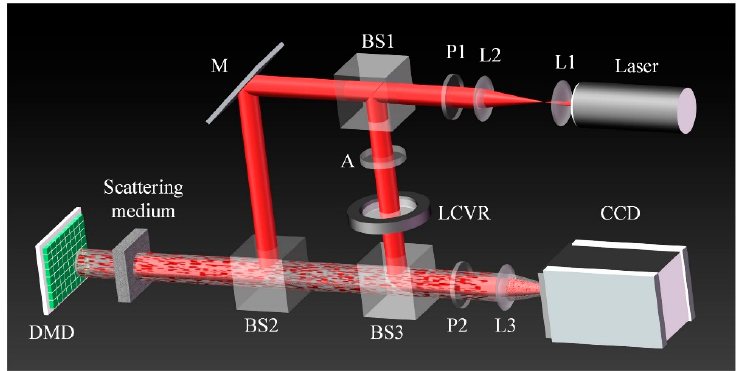
Figure 2. Experimental setup. Scattering medium (a 220-grit and a 1500-grit Thorlabs Optics ground-glass diffuser are stacked together to enhance the scattering ability), DMD: digital micromirror devices (ViALUX, V-7001VIS, 1024 × 768 pixels), LCVR: liquid crystal variable retarder (Meadowlark Optics, D5020), CCD (Hamamatsu, C13440-20CU, 2048 × 2048 segments (pixels), the central 400 × 300 segments are used for imaging), L#: lens, P#: polarizer, BS#: beam splitter, A: attenuation film, M: mirror.